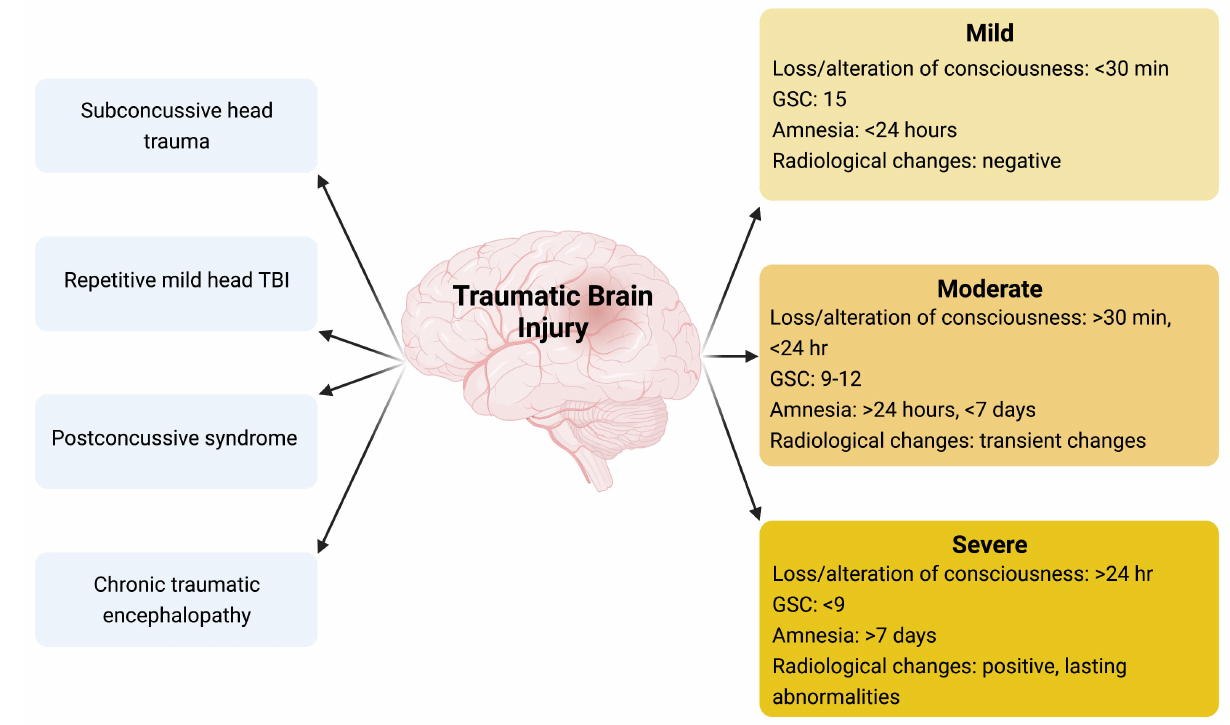
Fig. 1. Traumatic brain injury (TBI) can be classified as mild, moderate and severe based on symptoms manifestation. TBI can also be classified into subconcussive head trauma, repetitive mild head TBI, postconcussive syndrome, and chronic traumatic